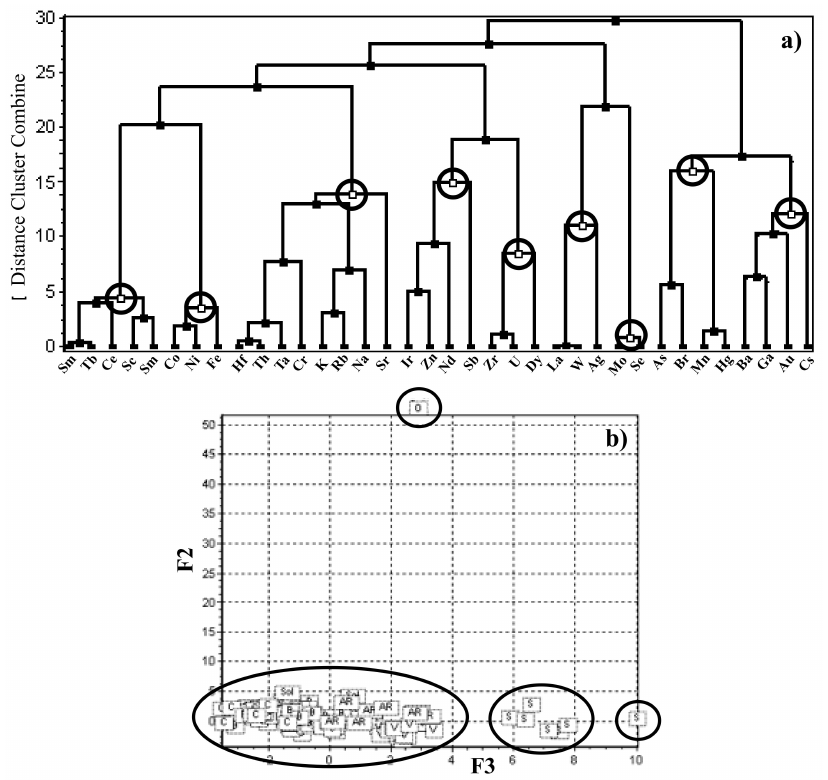
Figure 4. Chemometric approach: ( a ) hierarchical variable clustering analysis based on dendrogram showing the relationship among the elements and ( b ) and principal component analysis